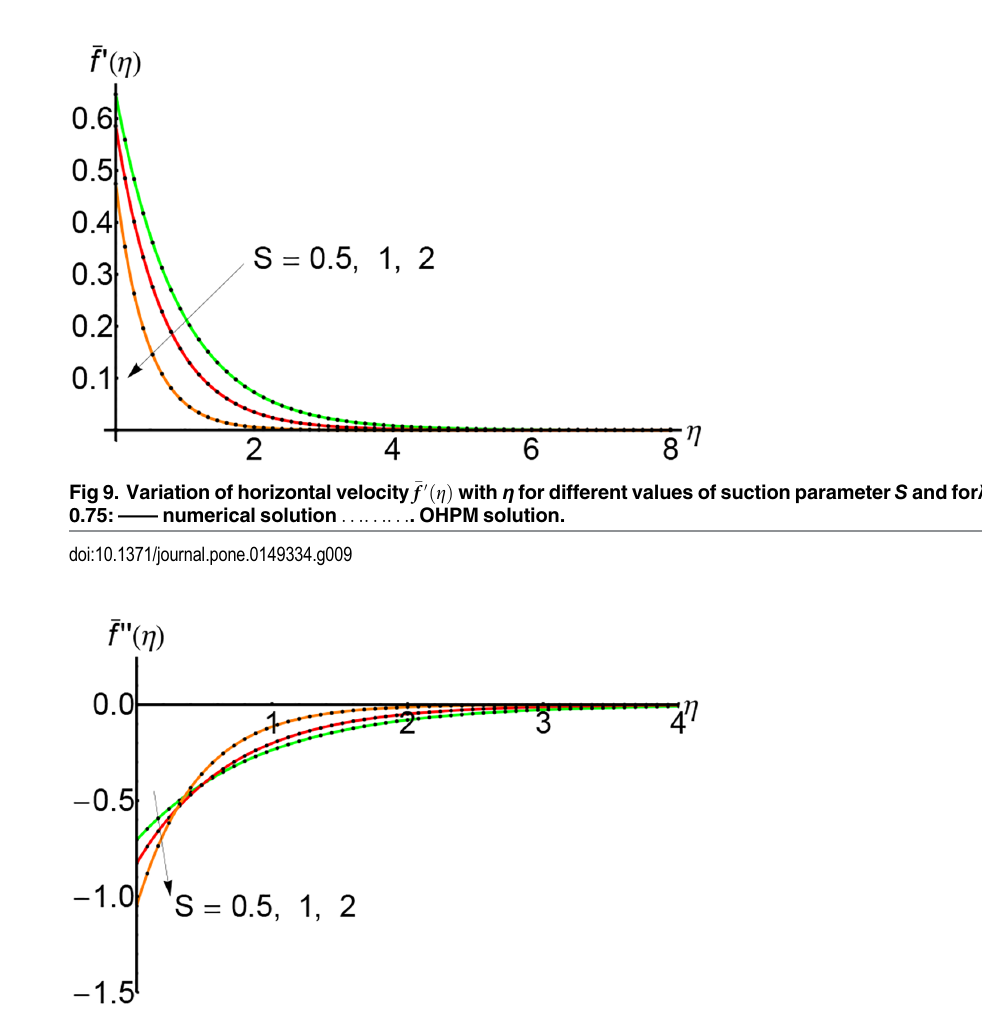
PLOS ONE | DOI:10.1371/journal.pone.0149334 March 31,